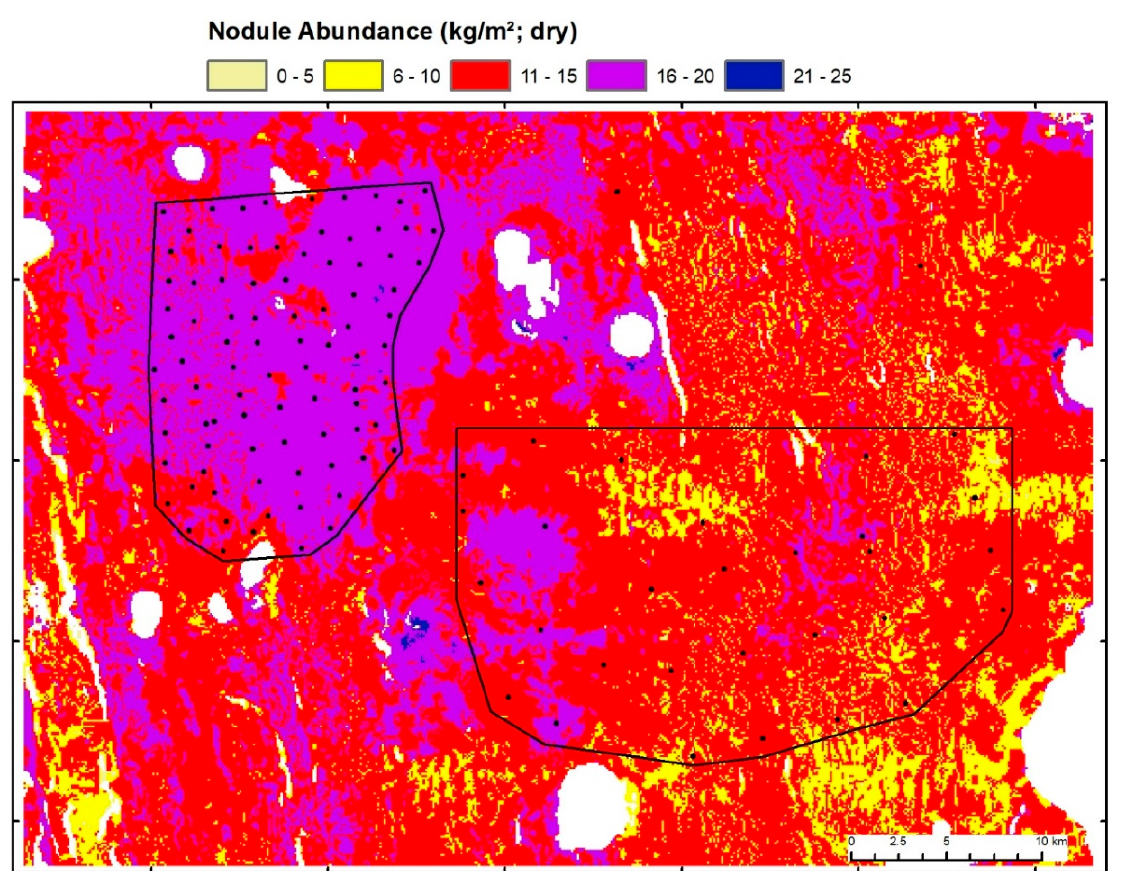
Figure 20. Distribution of manganese nodule abundance in PA1 based on the ANN model. Sub-areas and box core sites are indicated. Seamounts and slopes above 7° have been removed (white areas).